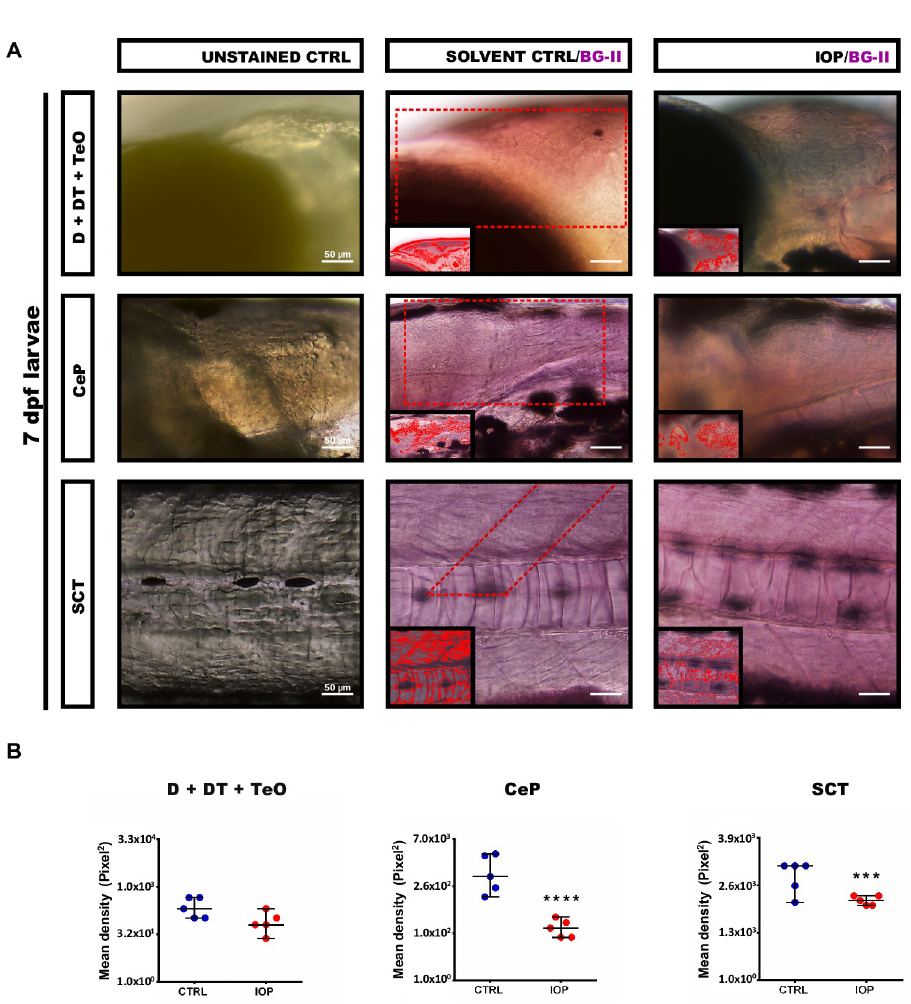
Fig 3. Whole-mount Black-Gold II staining of zebrafish larvae at 7 dpf. (A) Photomicrograph with lateral view and R-C orientation, whole-mount Black-Gold II staining in D + DT + TeO; CeP and SCT at 7 dpf (Unstained CTRL, Solvent CTRL/BG-II and IOP/BG-II), scale bar: 500 μ m and 50 μ m. In each corner, the amplification of sagittal sections identifying the selected area for analysis and the positive myelin pixels, recognized by the IPP6 program; (B) Graph showing the quantification of myelin density expressed as myelinated area (MA) in pixels 2 (individual values and mean ± SEM with n = 5/condition). Statistical analysis was performed with Student’s t test. ��� p < 0.001, ���� p <